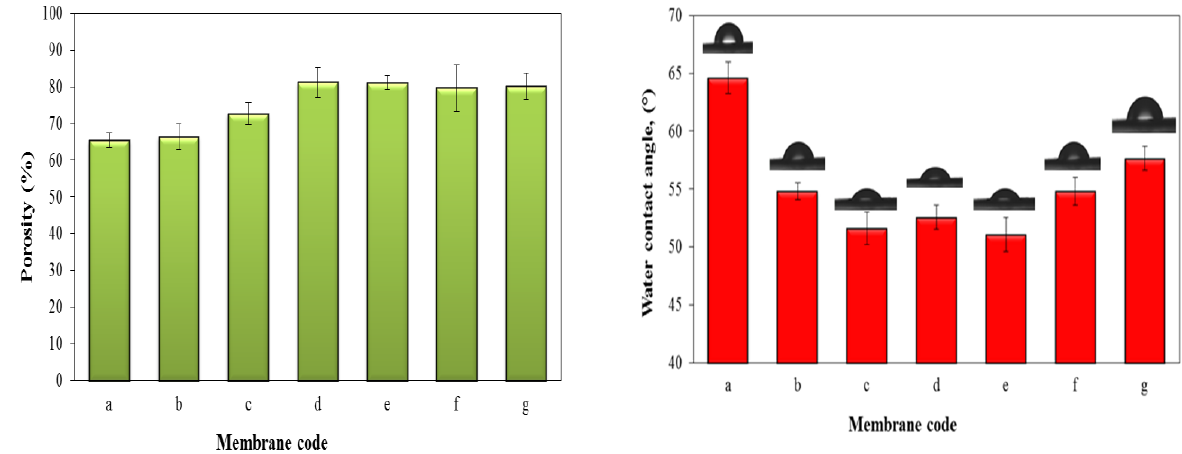
Figure 6. ( Left ) porosity; and ( Right ) contact angle of ( a ) PES, ( b ) PES/PTGM (1 wt.%), ( c ) PES/PTGM (3 wt.%), ( d ) PES/PTGM (5 wt.%), ( e ) PES/PTGM (7 wt.%), ( f ) PES/PTGM (9 wt.%),